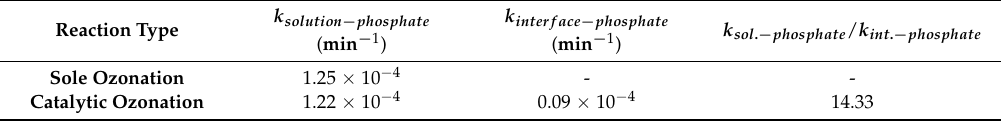
Table 4. k solution − phosphate / k interface − phosphate ratio in different reactions.